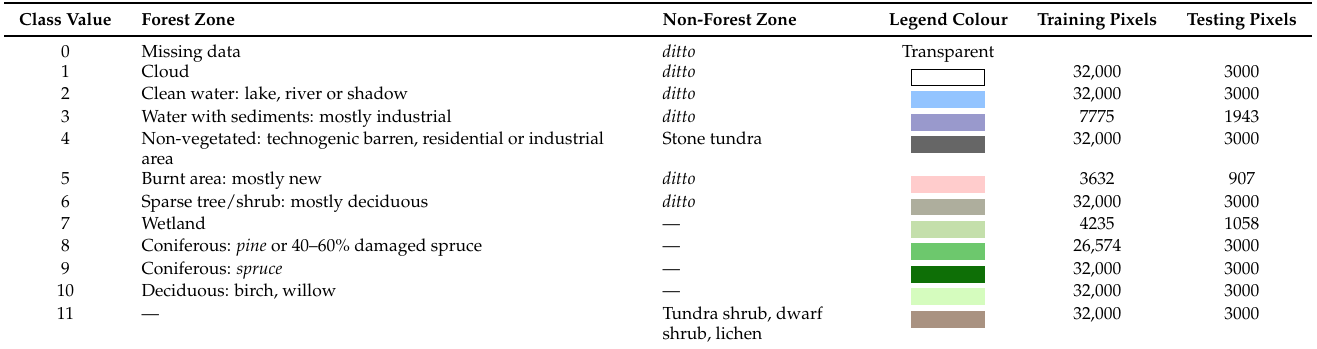
Table 4. Classes used in the Tensorflow classification of Landsat images along with their class value in the resulting TIFF file, class description and legend colour. The last two columns provide the number of pixel values used for training and testing the